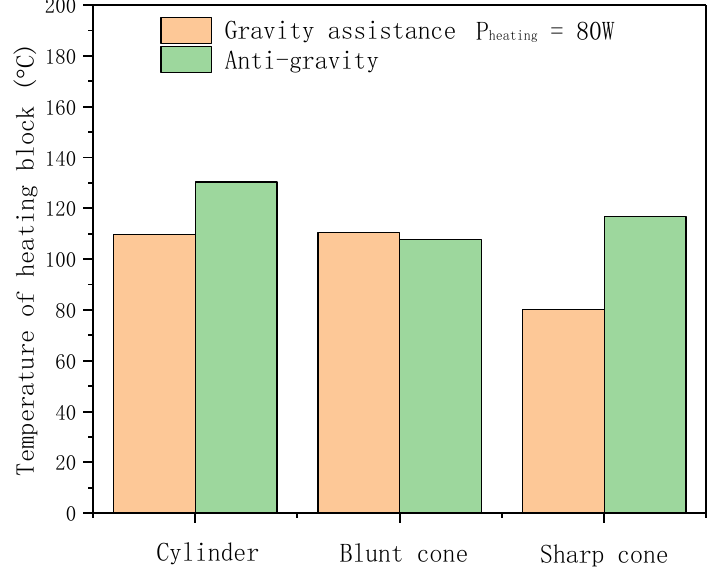
Figure 9. Temperature of heating block.